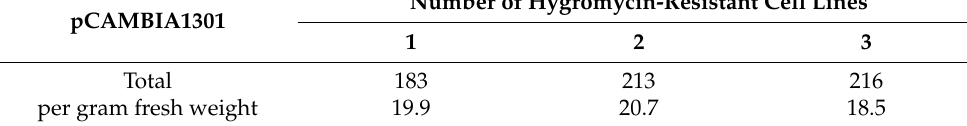
Table 2. Transformation efficiency in three separate experiments with pCAMBIA1301. Experiments with the pCAMBIA1301 vectors were carried out with 9.2, 10.3, and 11.7 g fresh weight of embryogenic tissue, respectively. The transformation efficiencies are expressed as the numbers of hygromycin- resistant cell lines per gram fresh weight of co-cultivated embryogenic tissue. Oligonucleotide primers used in the